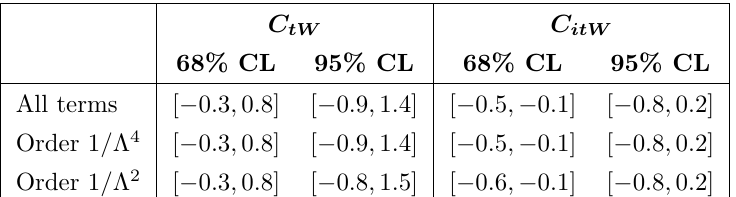
Table 7 . Obtained limits on the real ( C tW ) and imaginary ( C itW ) coefficient of the O tW operator. Also shown are the limits when only the terms up to a specific order in Λ are taken into account.